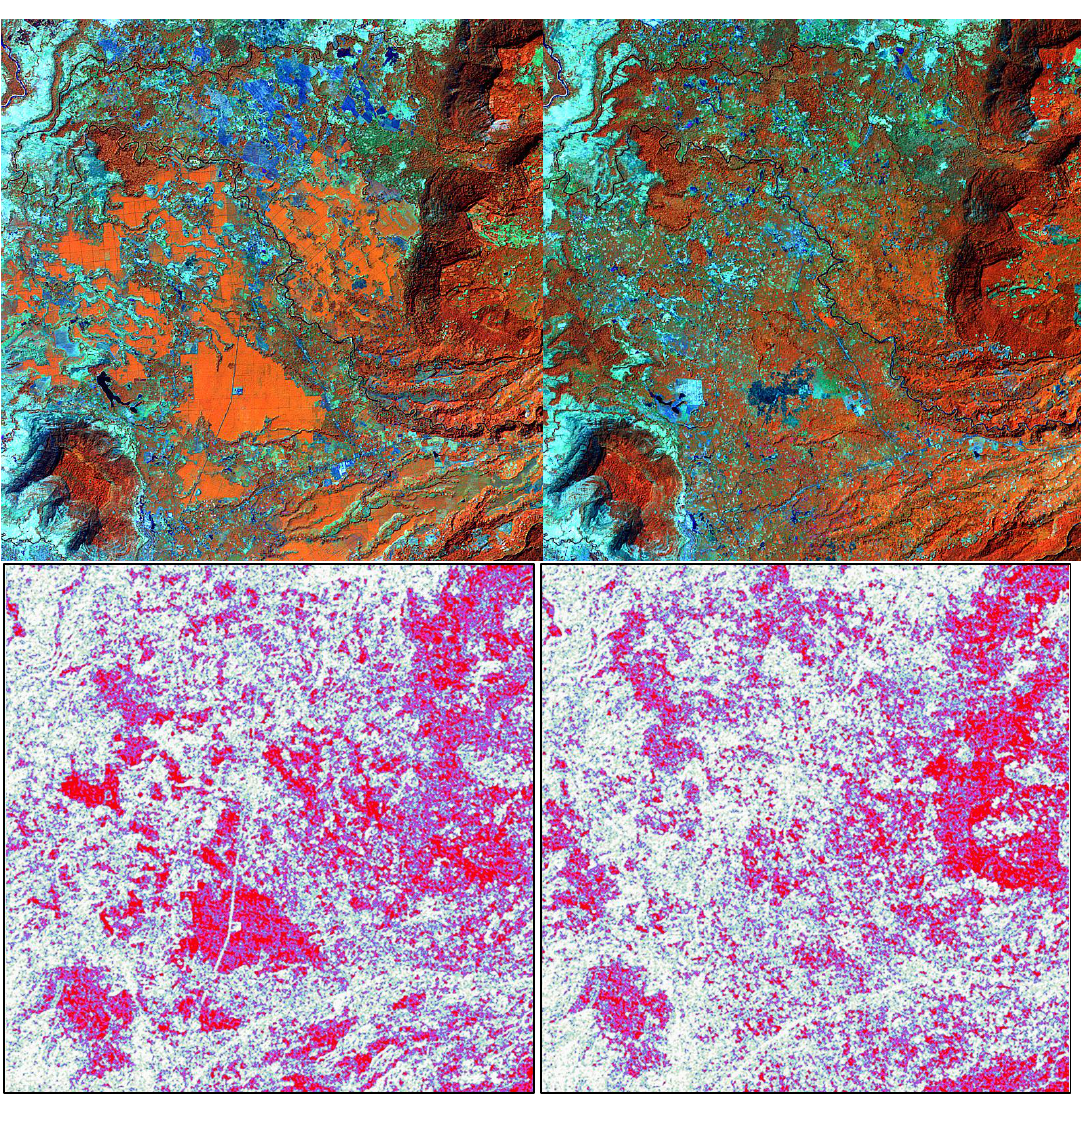
Figure 6. Landsat satellite views of rubber plantations in one sample location (top) and corresponding changes in landscape homogeneity (defined as decreases in contrast) quantified by image texture (bottom) in southern Laos. The image in the top the left was acquired in 2002 before the major expansion in rubber plantations took place. The image on the top right was acquired in 2011 following the major expansion. Landscape homogeneity is defined as lack of contrast between pixel values in a local image window or neighborhood.